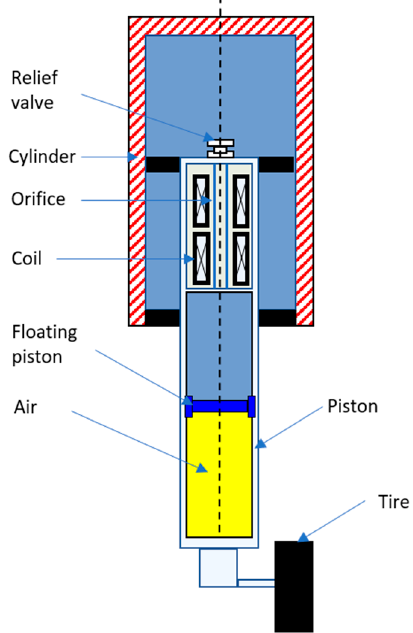
Figure 13. Schematic of the MR damper for the landing gear [169]. Reproduced with permission from Luong, Q. V. et al. Semi-Active Control for a Helicopter with Multiple Landing Gears Equipped with Magnetorheological Dampers; published by Applied Sciences, 2021.